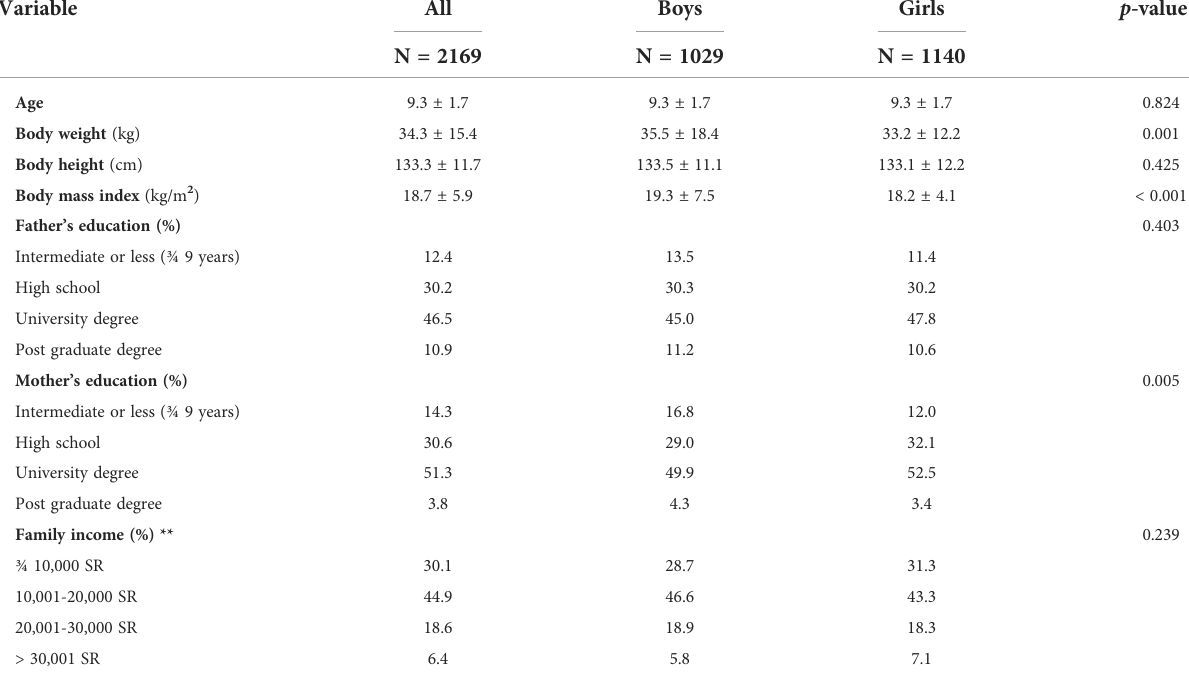
TABLE 1 Descriptive characteristics of the participants relative to sex.